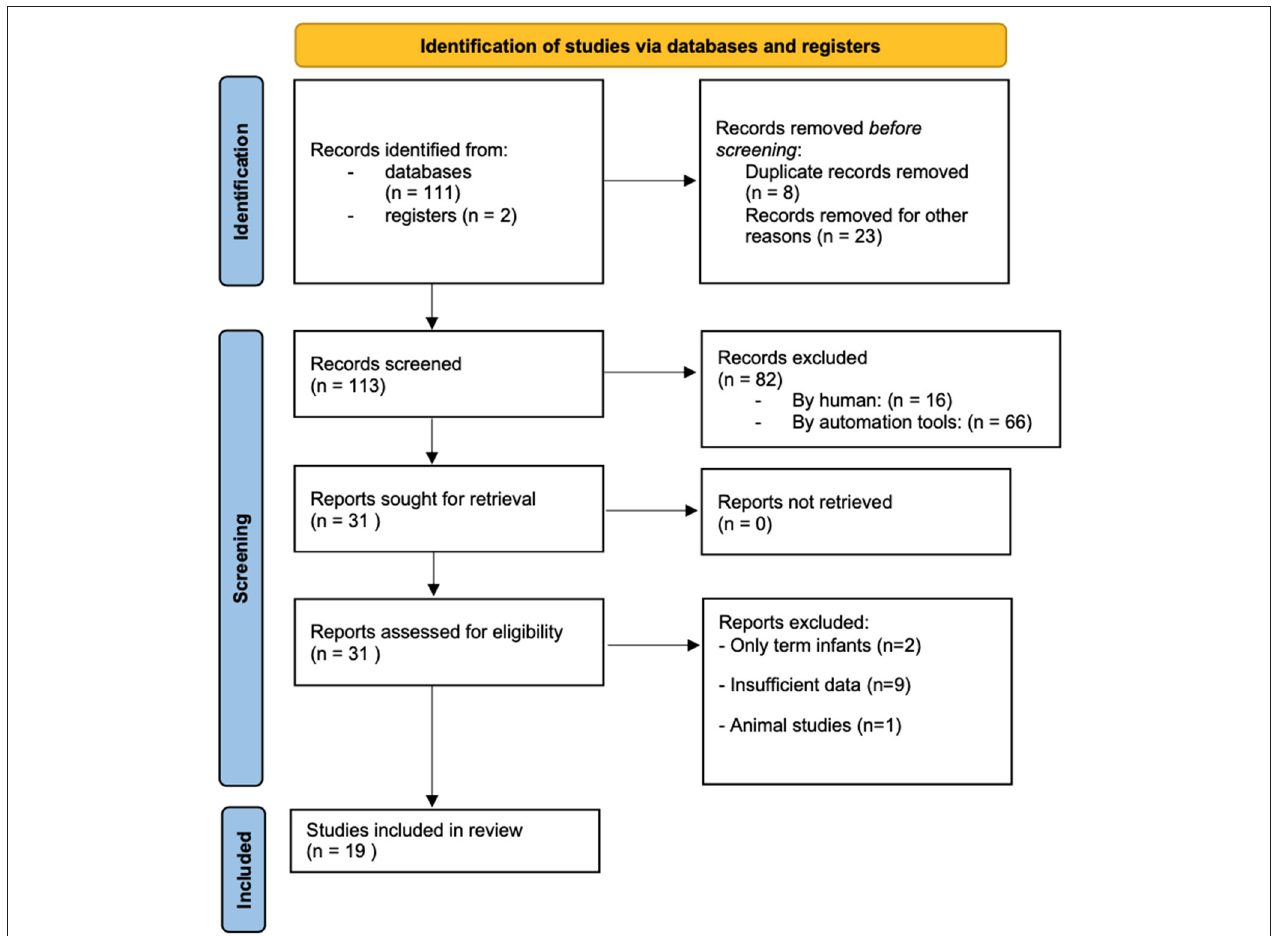
FIGURE 1 | PRISMA 2020 flow diagram of the studies selected for